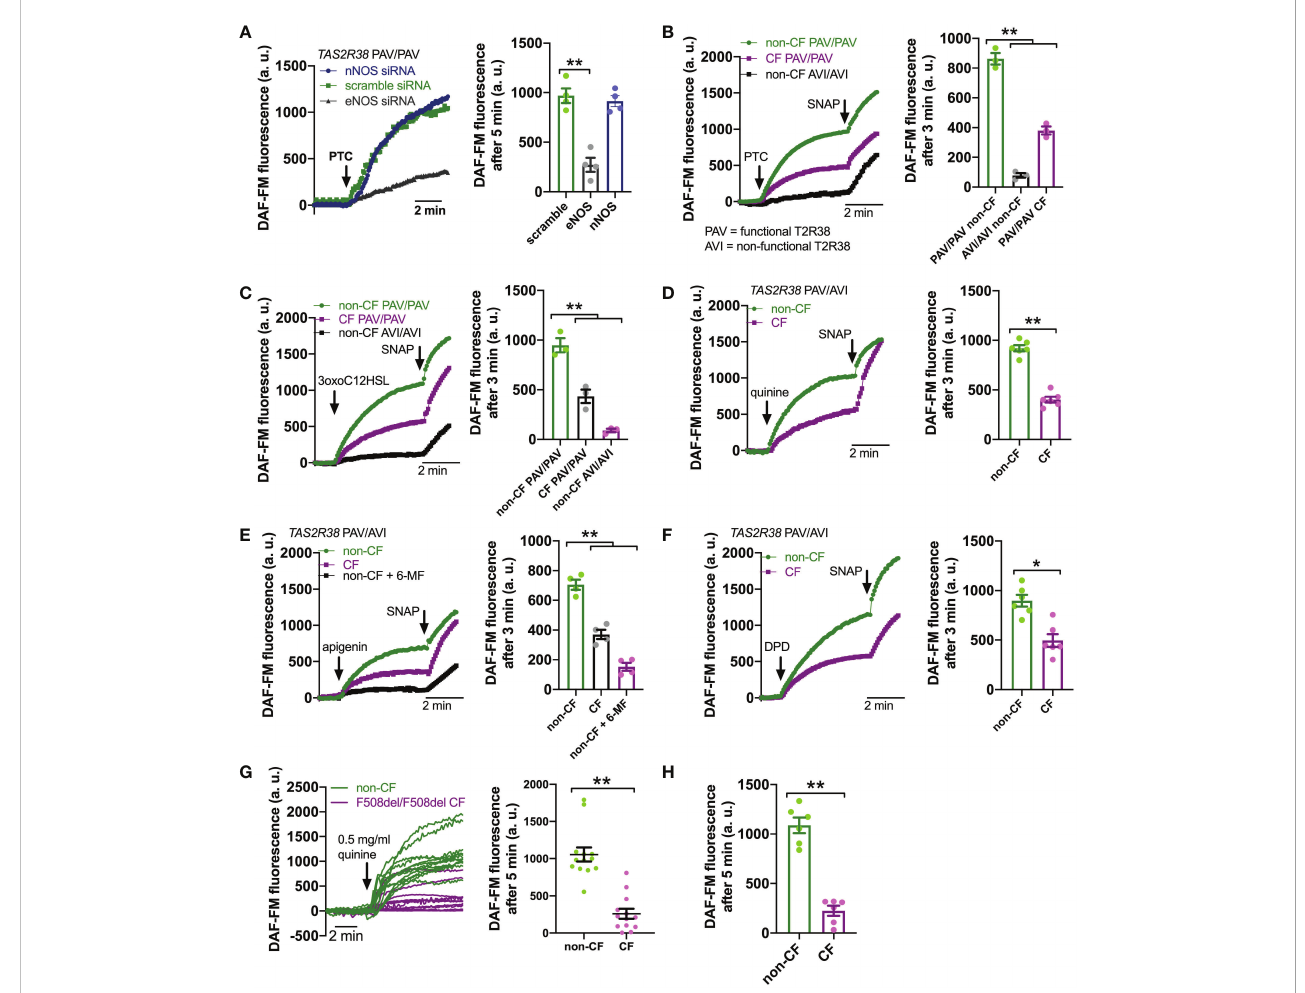
FIGURE 3 Reduced T2R-Stimulated No Responses In CF Nasal Cells. (A) Left, representative traces of DAF-FM fl uorescence, a dye that terminally reacts with NO and reactive nitrogen species and becomes fl uorescent in primary nasal air-liquid interface cultures (ALIs). Nasal ALIs were genotyped as PAV/PAV (homozygous functional T2R38) and stimulated with T2R38 agonist phenylthiocarbamide (PTC; 1 mM). Cells were previously treated during differentiation with siRNA directed against endothelial or neuronal nitric oxide synthase (eNOS or nNOS, respectively) or scramble siRNA. Right shows bar graph of data from independent experiments using ALIs from separate individual patients. eNOS siRNA signi fi cantly reduced PTC-stimulated NO production by one-way ANOVA with Dunnett ’ s posttest (scramble siRNA as control). (B) Traces (left) and bar graph (right; each point represents